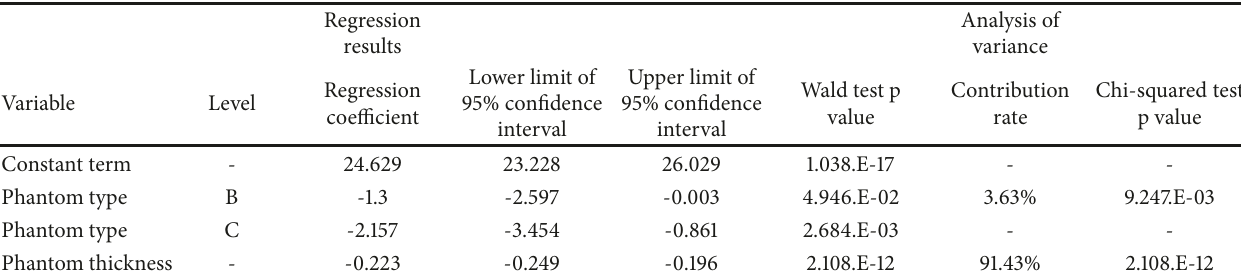
Table 7: Results of multivariate linear regression analysis using CNR as the objective variable and phantom type and phantom thickness as the explanatory variables.